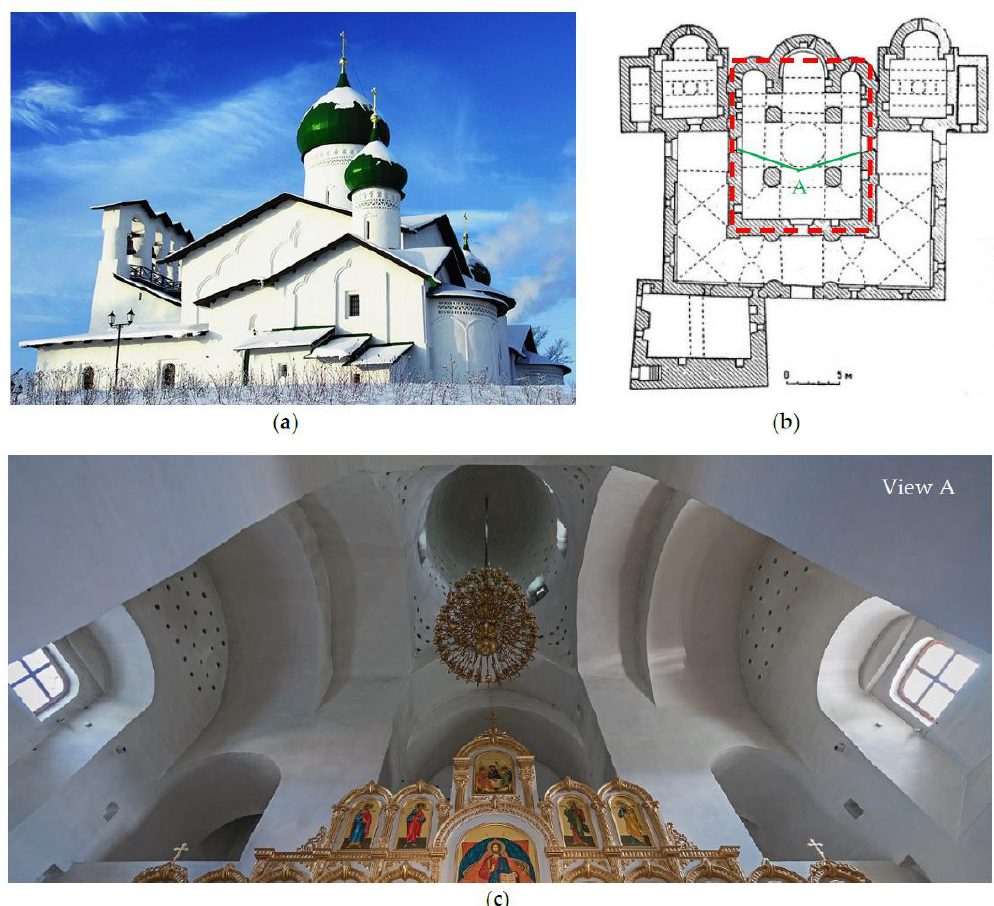
Figure 3. Church of Theophany (constructed in 1496) in Pskov with belfry: the southern facade ( a ), the plan of the ground floor ( b ), the vessels in a drum, pendentives and upper parts of walls ( c ). The red rectangular on the plan shows a main room of the church, green lines define the viewing angle of the photo inside the maim room.